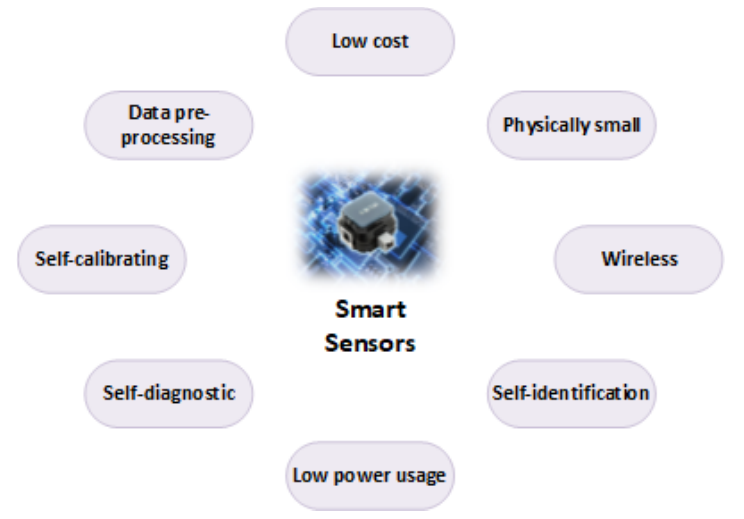
Figure 3. Features of a smart sensor.